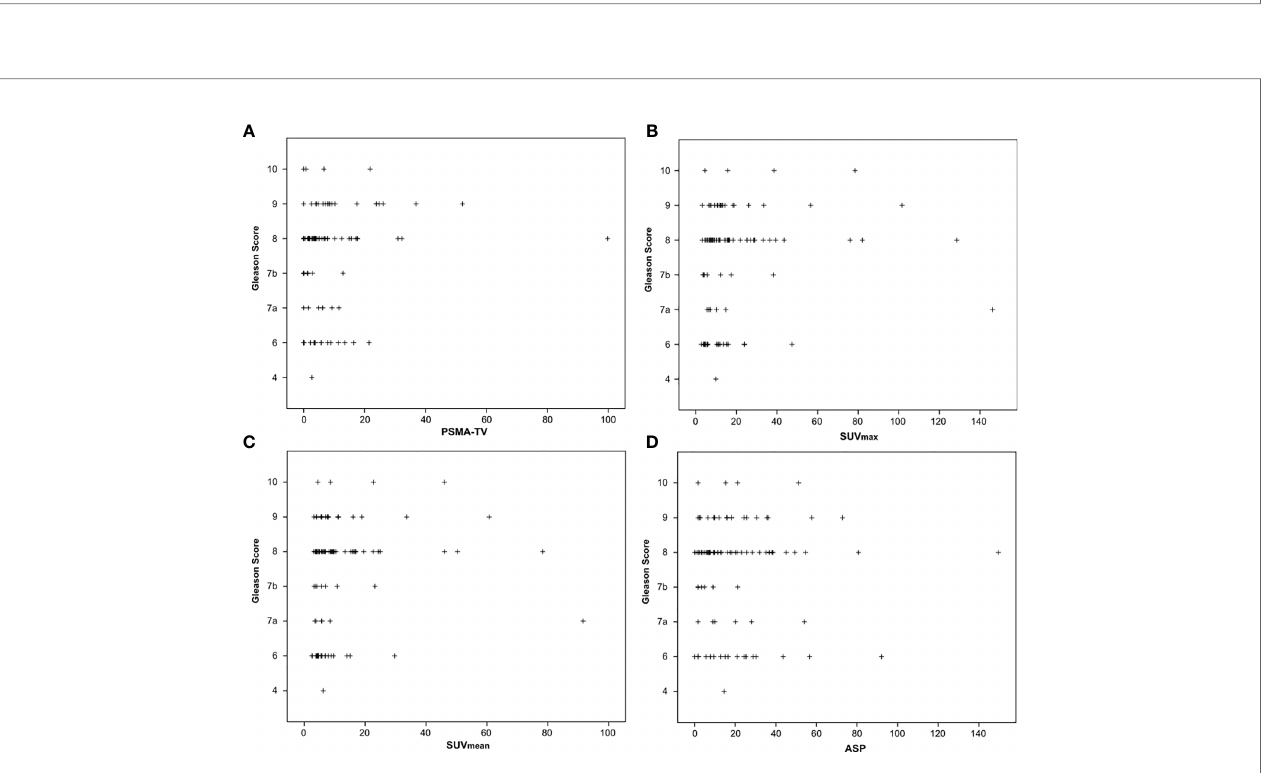
FIGURE 1 | Correlation between serum prostate-speci fi c antigen (PSA) values and quantitative PSMA-PET parameters. (A) PSMA-derived tumor volume (PSMA- TV), (B) Maximum standardized uptake value (SUVmax), (C) Mean standardized uptake value (SUVmean) and (D) Tumor asphericity (ASP). PSA values are plotted on a logarithmic scale.